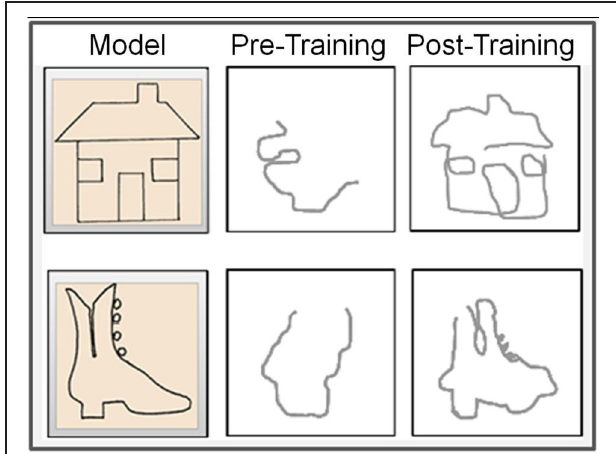
FIGURE 10 | Representative examples of pre- vs. post-training drawings. The left panels show the respective raised-line models to be drawn. Note the significant advance from practically unrecognizable drawings before training (middle panels) to well-recognizable drawings achieved by this totally blind subject as a result of the Cognitive-Kinesthetic training (right